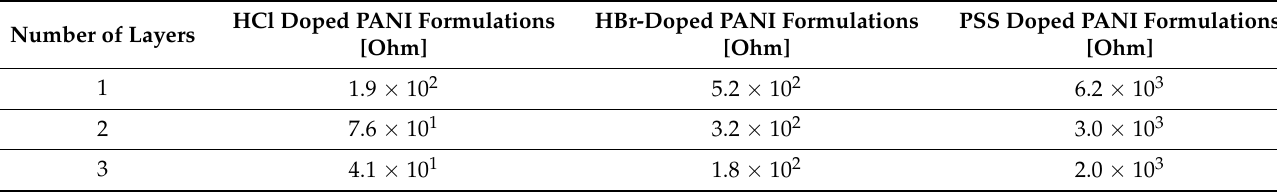
Table 2. Resistance of paints under investigation.